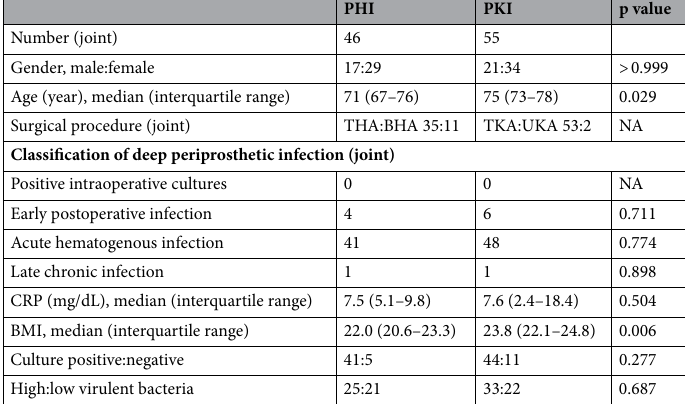
Table 1. Baseline characteristics of the patients. PHI periprosthetic hip infection, PKI periprosthetic knee infection, THA total hip arthroplasty, BHA bipolar hip arthroplasty, TKA total knee arthroplasty, UKA unicompartmental knee arthroplasty, NA not available, CRP C-reactive protein, BMI body mass